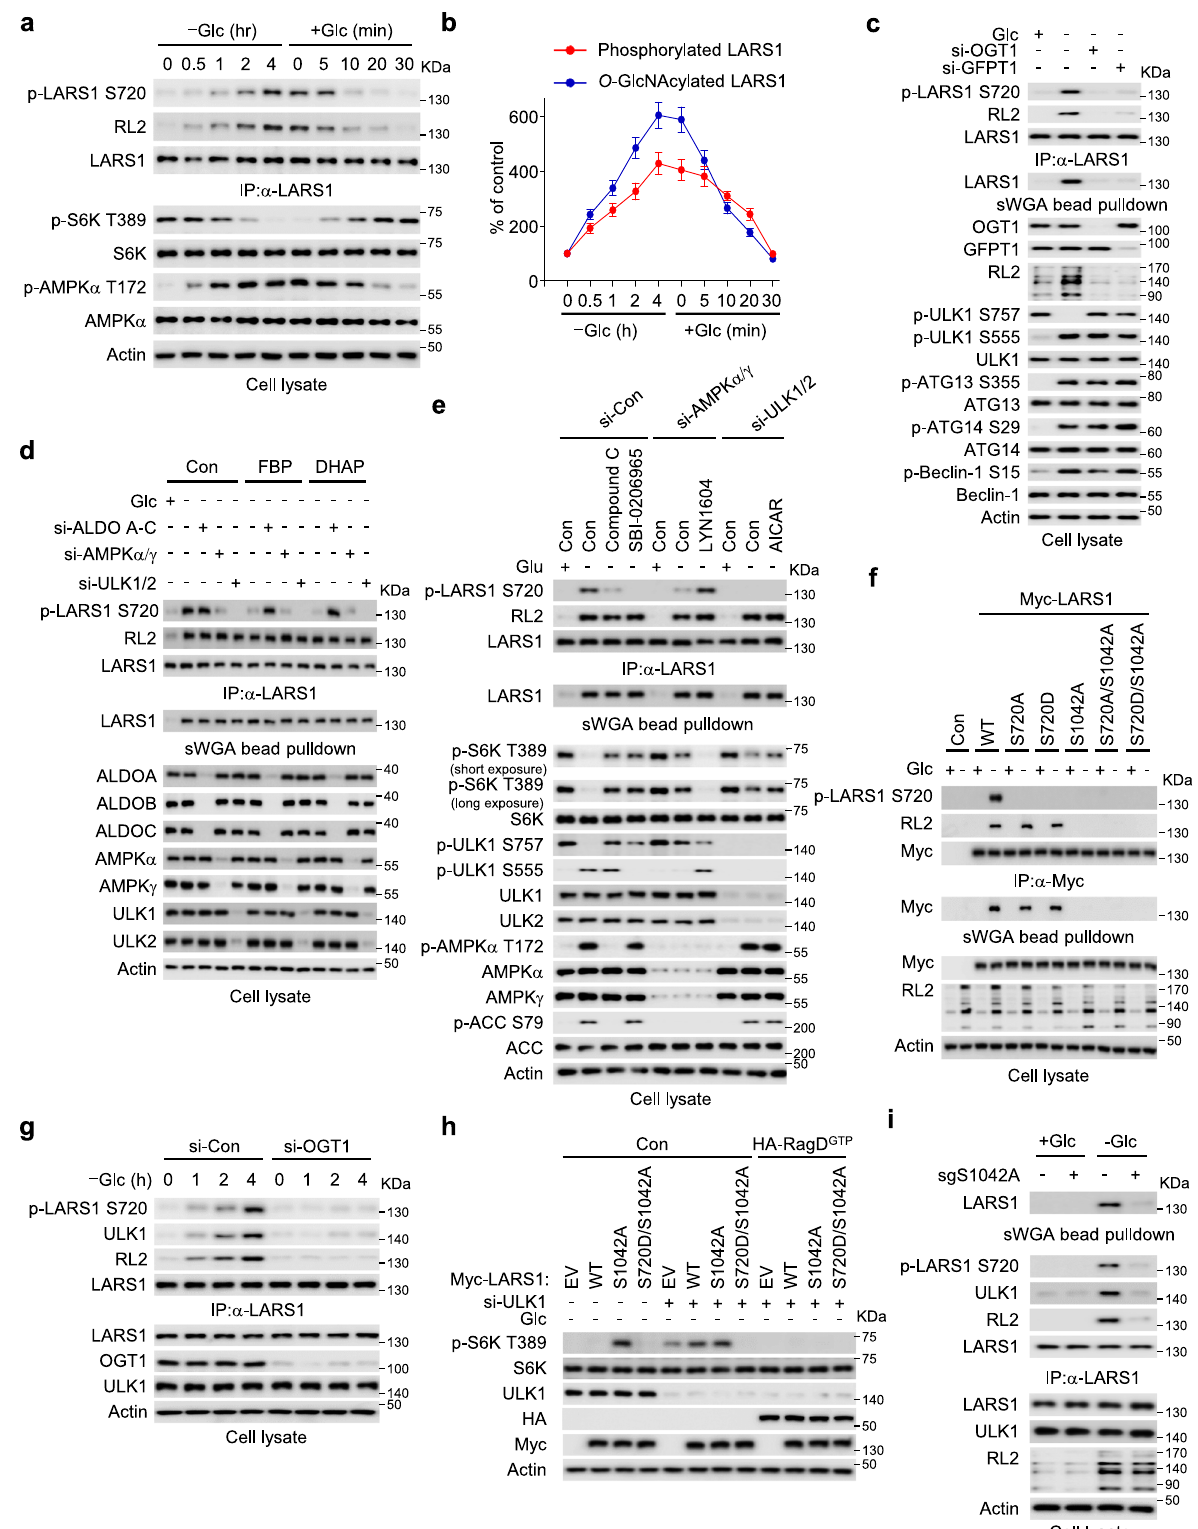
cells displayed enhanced S6K T389 phosphorylation upon glucose starvation when compared to the control, WT cells (Fig. 3e). These data indicate that O -GlcNAcylation of endogenous LARS1 at S1042 regulates its own phosphorylation by ULK1 and acts as an upstream regulator of Rag-dependent mTORC1 activation in the absence of